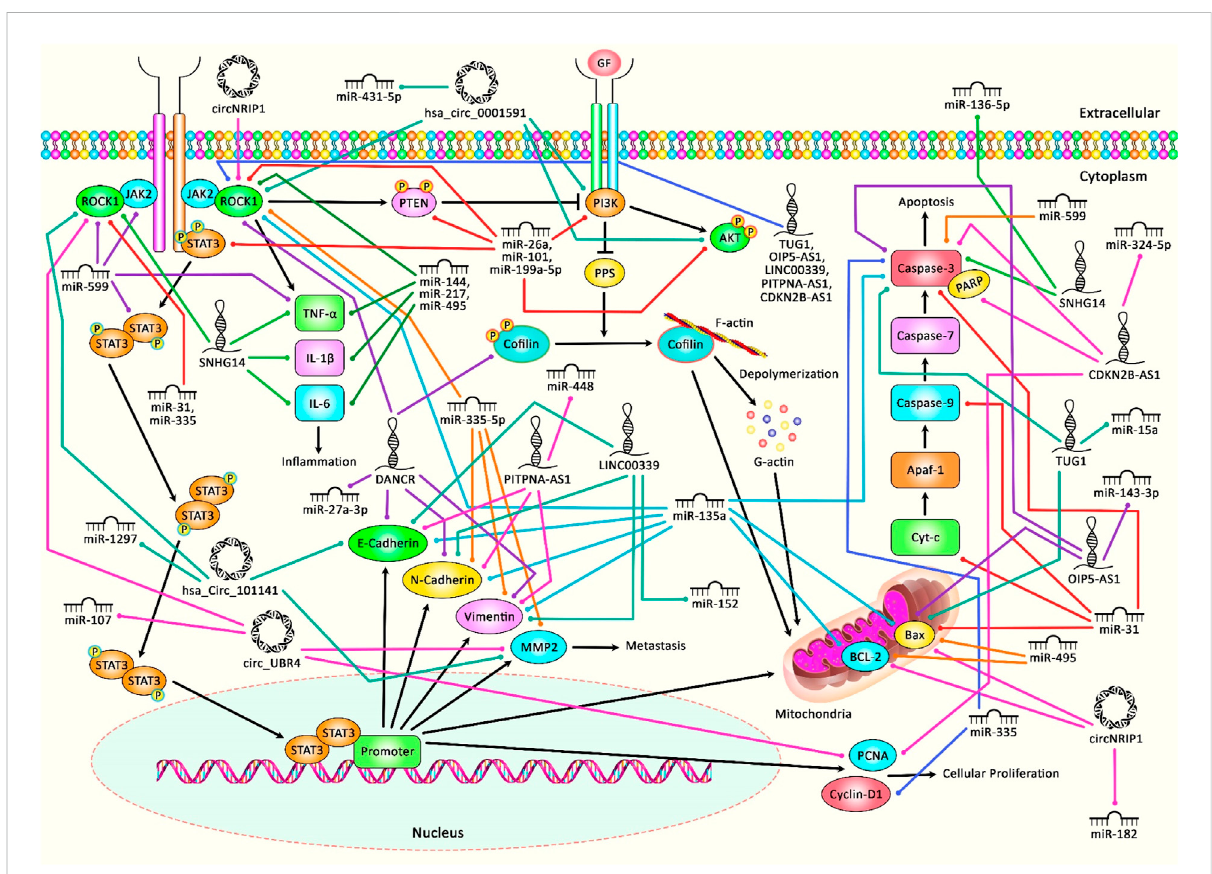
FIGURE 1 A schematic diagram of the role of several ncRNAs in triggering the ROCK1 signaling pathway in human disorders and malignancies. OverexpressionofROCK1couldresultintriggeringtheactivationofPTENandPI3K,leadingtoPP1andPP2Aupregulation,anddephosphorylationof co fi lin that could bind to G-actin and translocate to mitochondria, and eventually could cause cytochrome c release, caspases activation and apoptosis. ROCK1 could also play an effective role in activating and rapidly phosphorylating JAK2, which in turn could enhance downstream signaling cascades containing STAT3 and PI3K. Previous studies have authenticated that several ncRNAs (miRNAs, circRNAs, and lncRNAs) could have a crucial role in regulating the ROCK1 pathway in various human diseases as well as cancers. All the information regarding the role of these ncRNAs in the modulation of this cascade can be seen in Tables 1 –